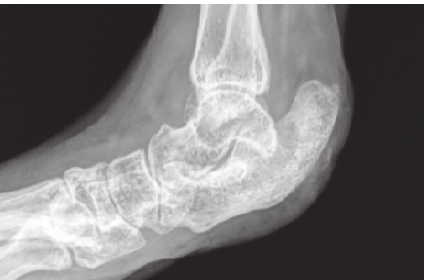
Figure 5: Control radiographs (33 days after surgery) illustrating the normalization of the calcaneal bone as well as the soft tissue structures around the ankle